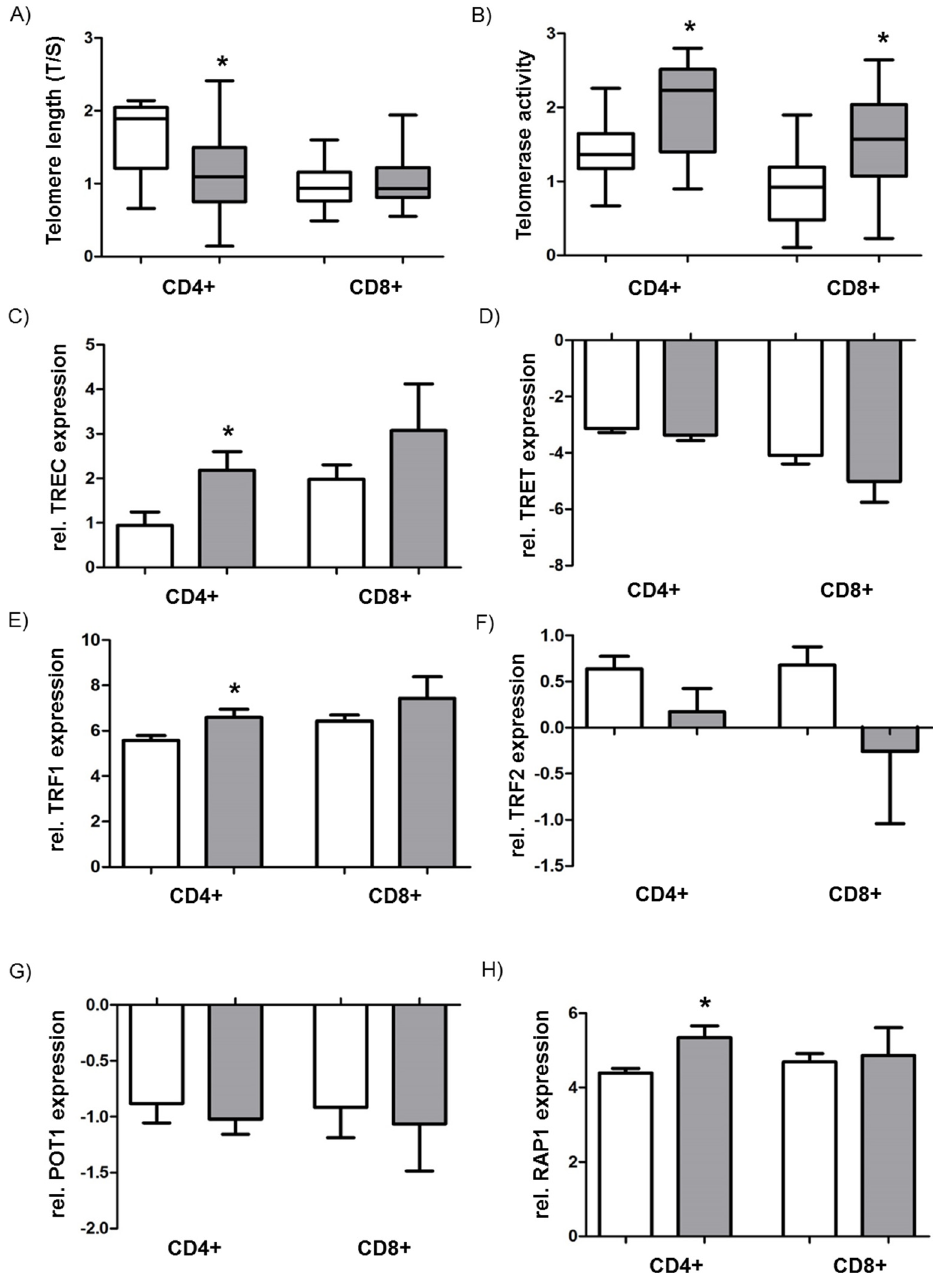
Figure 4. Analysis of telomere length, telomerase activity, and the shelterin complex. ( A ) Assessment of telomere length by T / S ratio in CD4 + and CD8 + T cells of septic patients (grey bar) and controls (white bar). ( B ) Telomerase activity determined by telomeric repeat amplification protocol (TRAP) assay in CD4 + and CD8 + T cells of septic patients (grey bar) and controls (white bar). ( C ) mRNA expression of TRET (telomerase reverse transcriptase) and ( D ) TERC (telomerase RNA component) in CD4 + and CD8 + T cells of septic patients (grey bar) and controls (white bar). mRNA expression of shelterin complex components TRF1 (Telomeric Repeat Factor 1) ( E ), TRF2 ( F ), POT1 (Protection of Telomeres 1) ( G ), and RAP1 (Repressor / Activator protein 1) ( H ) in CD4 + and CD8 + T cells of septic patients (grey bar) and controls (white bar). mRNA expression is provided as relative expression compared to the housekeeping gene GAPDH. Data are displayed as a box-and-whisker plot representing the 25th and 75th percentiles (bottom and top of the box), the median (band inside the box), and the minimum and maximum of all data (ends of the whiskers) for ( A,B ) Data are displayed as mean ± SEM for ( C – H ). Asterisks (*) denote statistical significance, with p < 0.05.